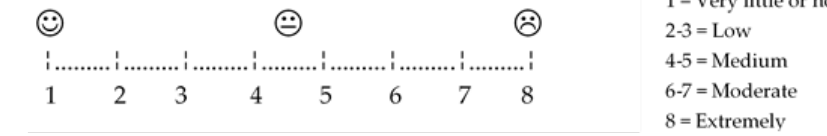
Figure 2. Likert-type scale with 5 score ranges. Satisfaction Scale.